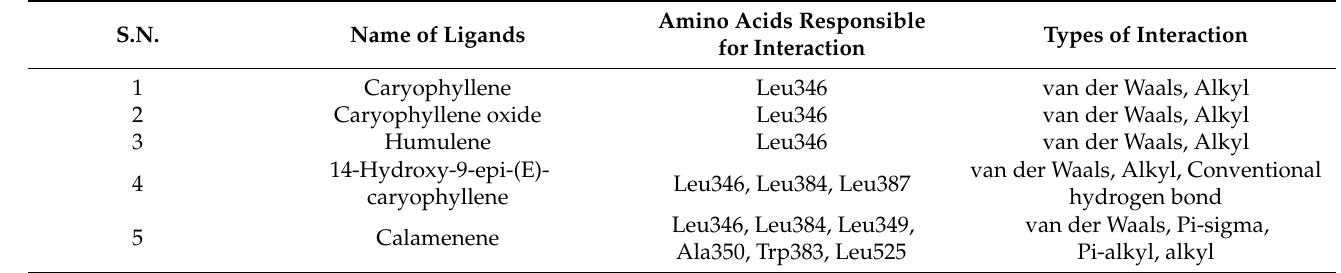
Table 4. Ligands and the amino acid responsible for the interaction and the type of interactions present. The amino acid involved in van der Waal’s interaction is not given in the table.